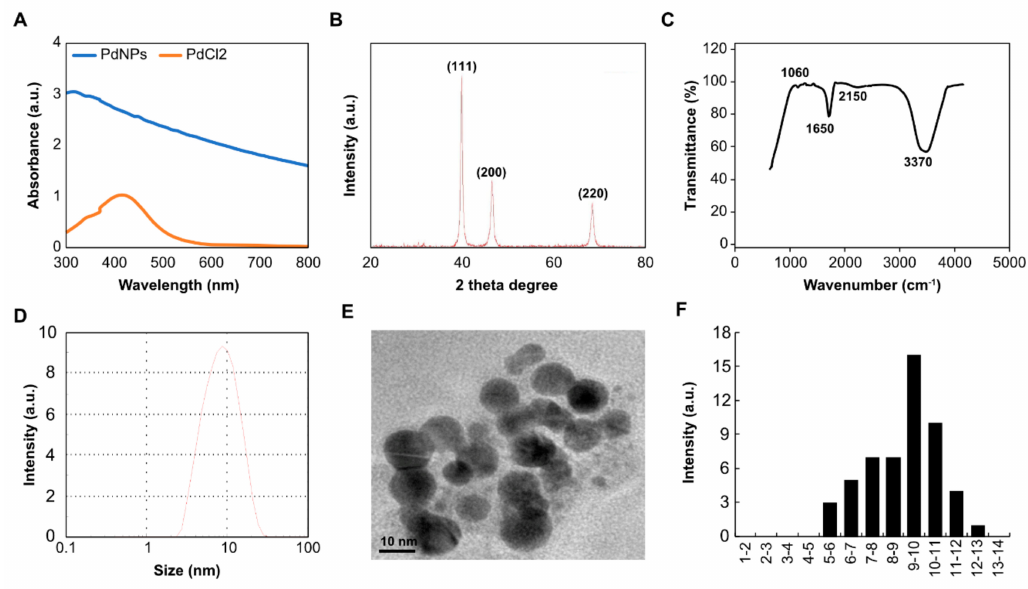
Figure 1. Synthesis and characterization of palladium nanoparticles (PdNPs) using resveratrol. ( A ) Ultraviolet-visible spectroscopy (UV-vis) absorption spectra of resveratrol-mediated synthesis of PdNPs ( B ). X-ray di ff raction patterns of PdNPs ( C ). Fourier-transform infrared spectroscopy (FTIR) spectra of PdNPs ( D ). Size distribution analysis of PdNPs using dynamic light scattering (DLS) ( E ). Transmission electron microscopy (TEM) images of PdNPs ( F ). Histograms showing particle size distribution. All experiments were performed three times to obtain reproducible results. The data represent the results of a representative